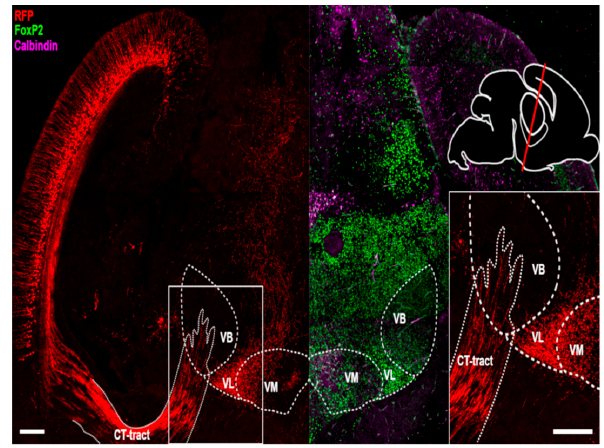
Figure 6. RFP + cortical fibers entering the thalamus, specifically the ventrobasal thalamic nucleus, at E18.5. Coronal section of an E18.5 mouse brain stained for FoxP2 (in green), calbindin (magenta) and Red Fluorescent Protein (in red), with zoomed-in inset, showing the RFP + corticothalamic fibers and another, separate, RFP + fiber bundle, presumably originating from the cerebellar nuclei. Top right, schematic showing the angle and rostro-caudal level of the coronal slices. Scale bars: main image = 250 µm, inset = 100 µm. CT-tract = corticothalamic tract, VB = ventrobasal nucleus, VL = ventrolateral nucleus, VM = ventromedial nucleus.